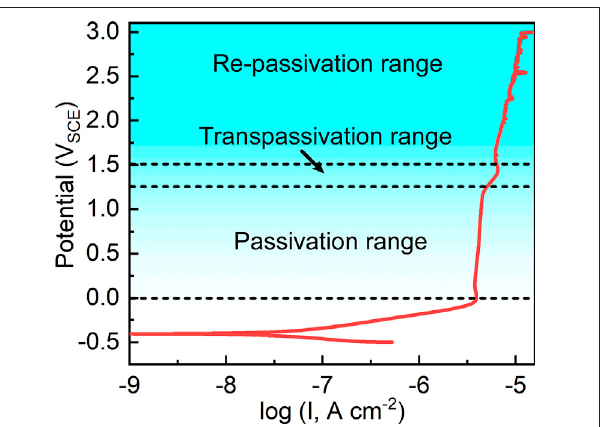
FIGURE 1 | X-ray diffraction pattern of as-cast Ti-6Al-4V used in this work.